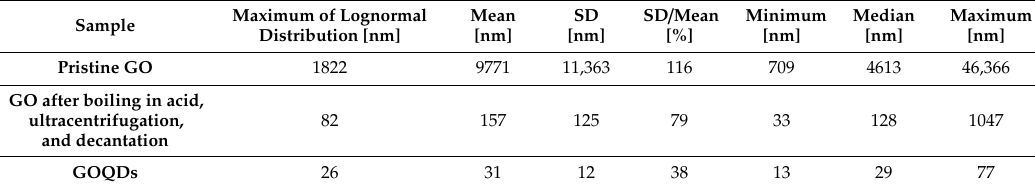
Figure 1. ( a ) SEM image of graphene oxide quantum dots (GOQDs) after filtration (100 nm cut-o ff ) spread over doped silicon substrate. Flake size histogram of ( b ) GO flakes bought from Nanopoz (red dashed plot); ( c ) GO flakes after boiling in acid, ultra-centrifugation, and decantation; and ( d ) GOQDs after syringe filtration. Table 1. GO and GOQDs flake size statistic.